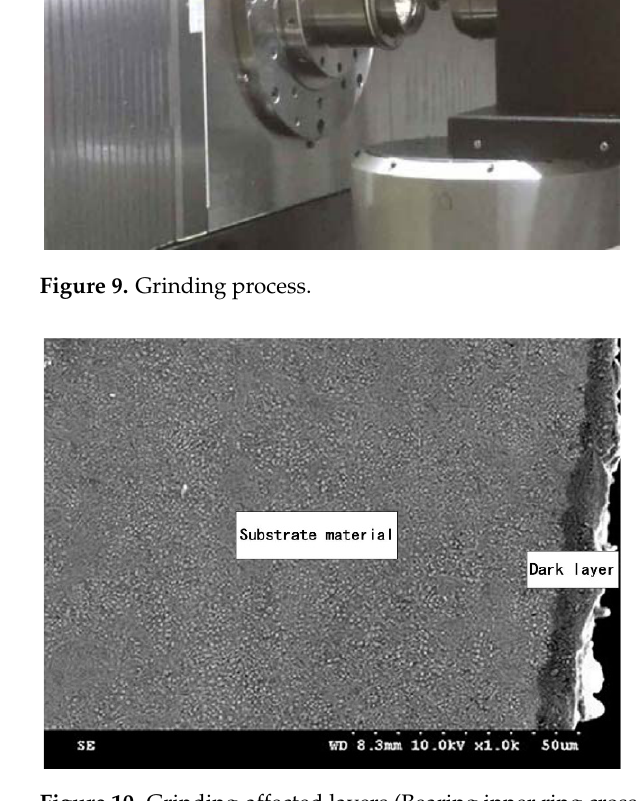
Figure 10. Grinding ‐ affected layers (Bearing inner ring cross section). Figure 10. Grinding-affected layers (Bearing inner ring cross Table 8. Comparison of bearing accuracy after grinding.